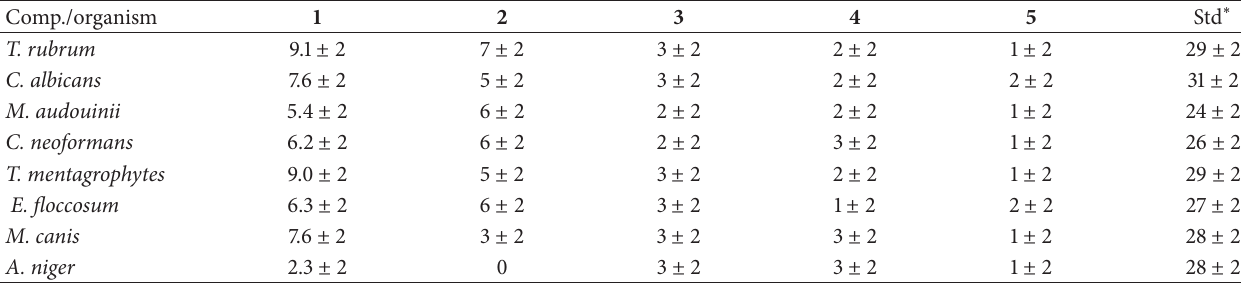
Table 2: Inhibition zones (mm) of 1–5 isolated from C. sativum against fungi. Comp./organism